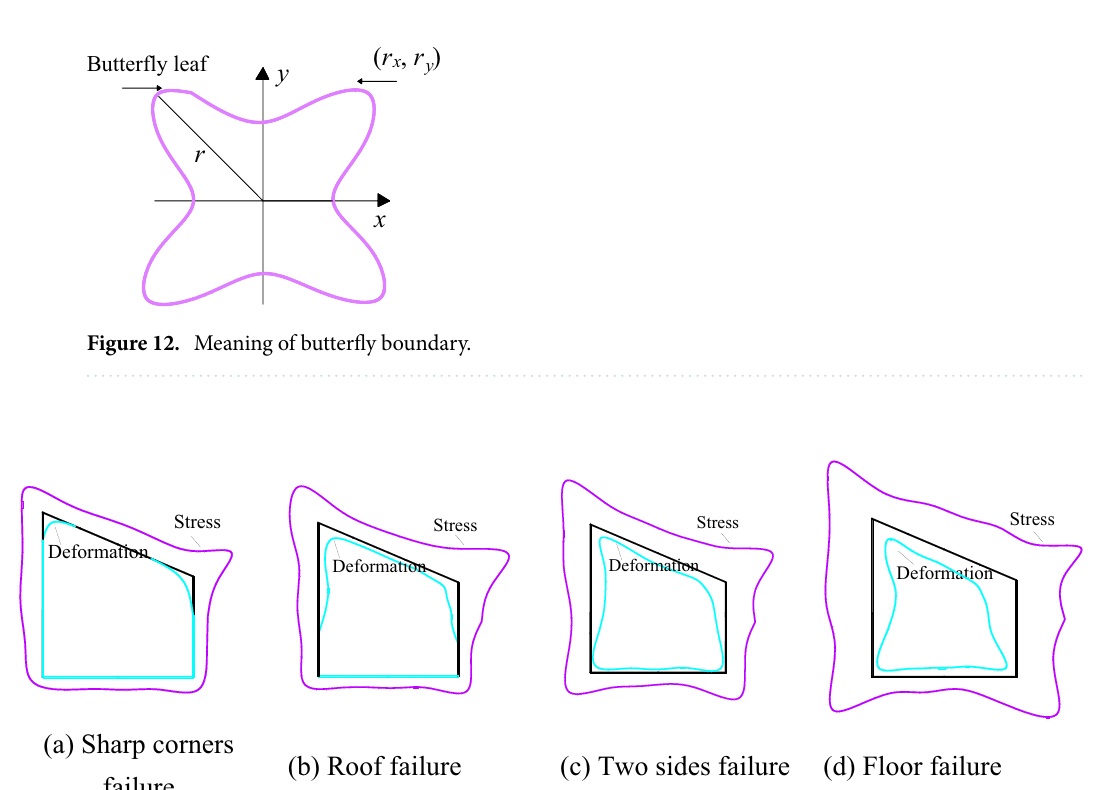
Figure 13. Cyclic deformation and failure of roadway surrounding